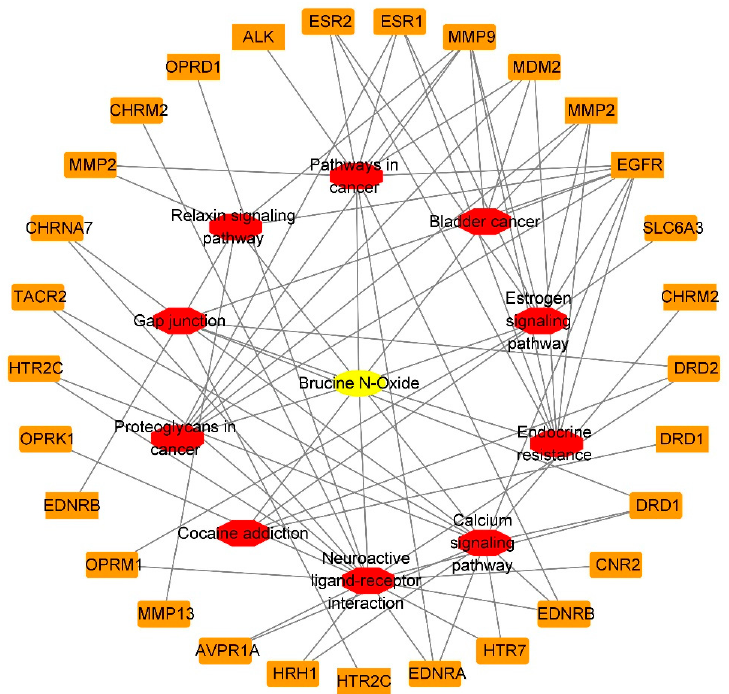
Figure 9. “Component-target-pathway” network of BNO (Yellow: compounds; red: pathways; orange: genes).